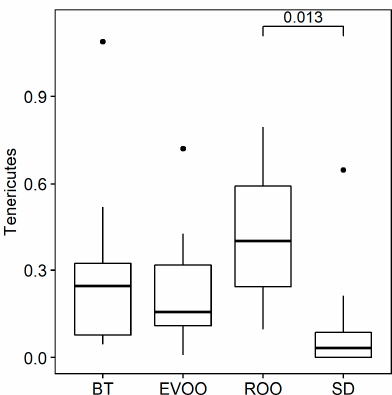
Figure 2. Box plots of presence of the phylum Tenericutes, in percentage of sequences, after feces DNA extraction from mice fed with the different diets. BT: butter diet; EVOO: extra virgin olive oil diet; ROO: refined olive oil diet; SD: standard chow. SD, EVOO, and BT diet values from Prieto et al. [12].